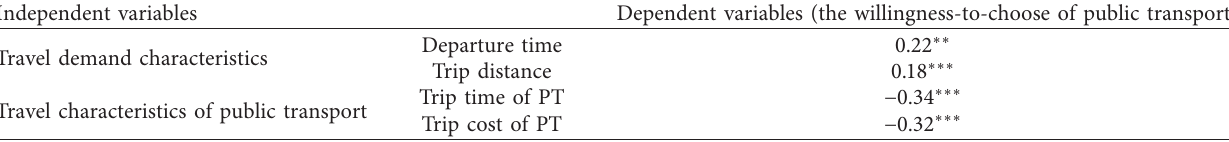
Table 9: Effect of travel demand characteristics and travel characteristics of public transport on the willingness-to-choose of public transport.